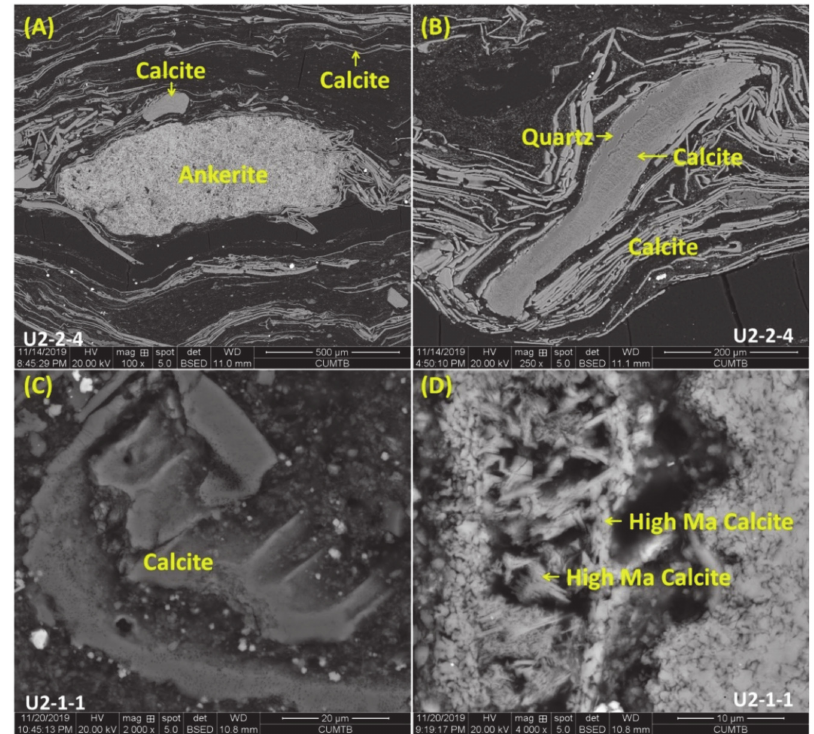
Figure 6. SEM backscattered electron images of calcite, high-Mg calcite, ankerite, and quartz in OS2 oil shales. ( A ) Calcite particles and massive ankerite in organic matter matrix surrounded by biogenic calcite; ( B ) biogenic calcite laminae along massive calcite and quartz; ( C ) calcite replacing cell wall; ( D ) high-Mg calcite crystals as void filling showing euhedral